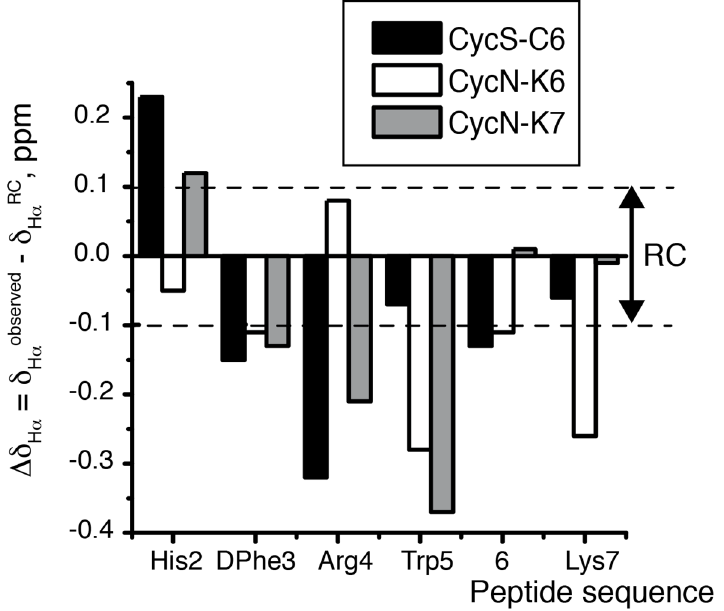
Figure 3. ∆ δ H α ( ∆ δ H α = δ H α observed − δ H α RC , ppm) plot as a function of sequence for peptides CycS-C6 (black bars), CycN-K6 (white bars), and CycN-K7 (grey bars) in aqueous solution at pH 2.5 and 25 °C. Residue 6 is Cys in CycS-C6 and Lys in CycN-K6 and CycN-K7 . Dashed lines indicate the random coil (RC) range. Random coil values were taken from [21].